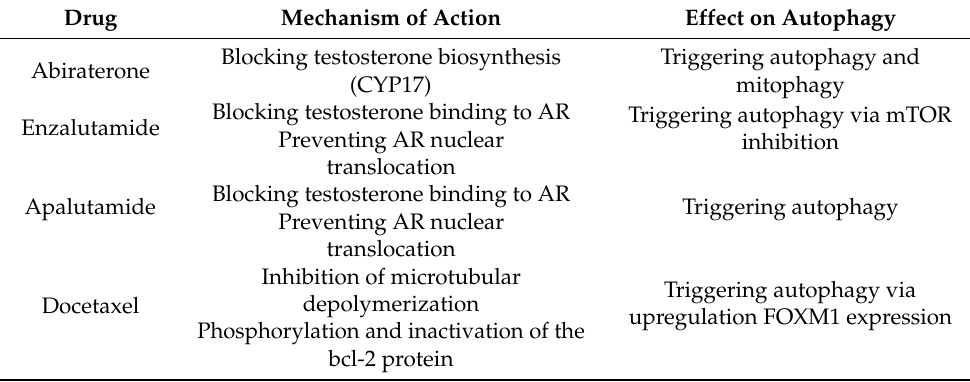
Table 2. Summary of PCa drugs interfering with autophagic